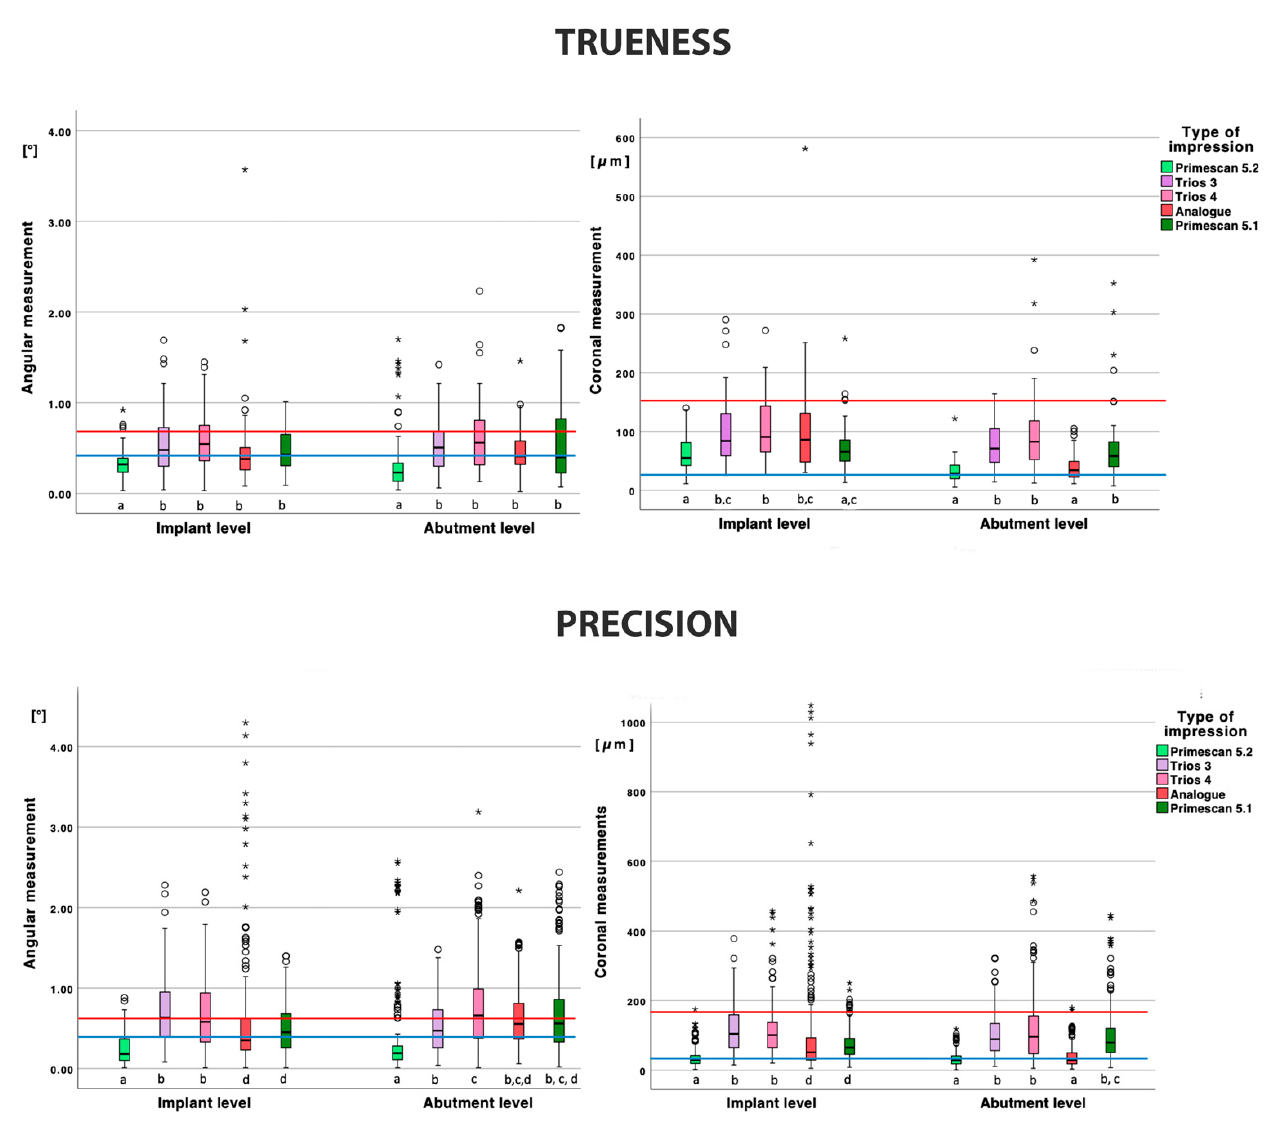
Figure 3. Boxplot for angular and coronal measurements for all types of impressions and for both connections. Boxplots labeled with the same letter (a,b c or d) in each of the eightgroups separately were not statistically significant ( p > 0.05). Red line: 0.75° or 150 µm; Blue line: 0.4° or 30 µm. Table 1. All descriptives for trueness and precision for both types of connection with p-values for the Mann–Whitney U-tests.